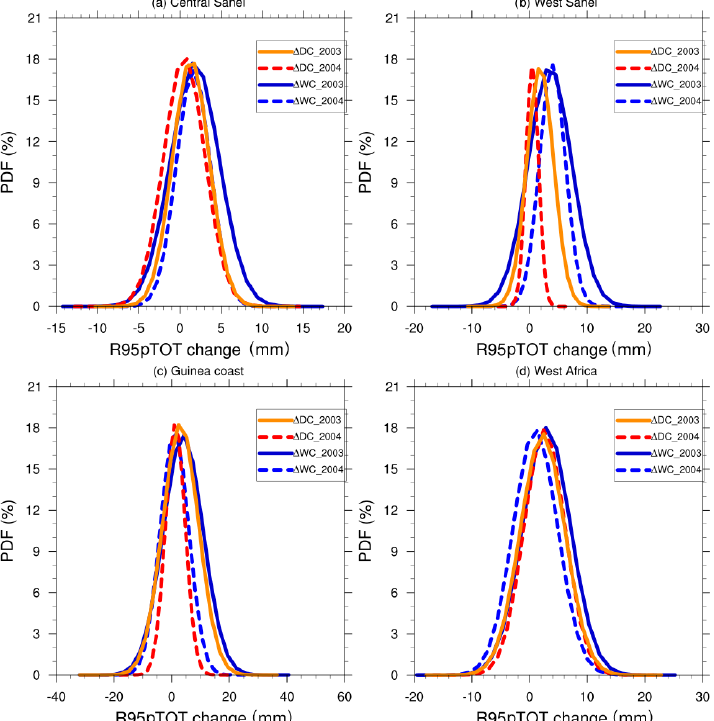
Hydrol. Earth Syst. Sci., 26, 731–754, 2022